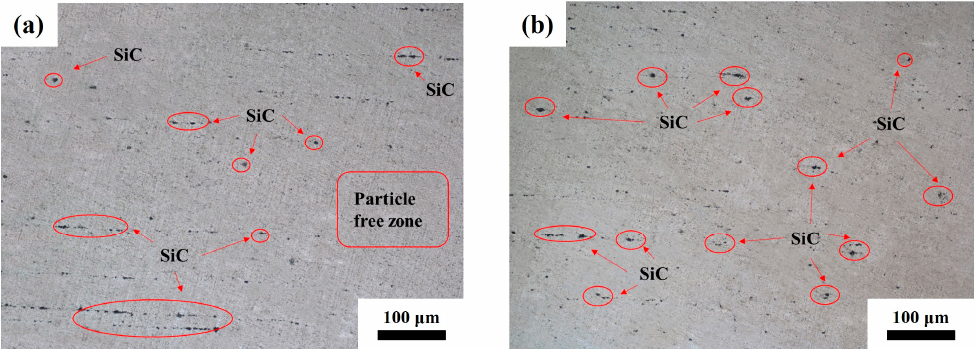
Figure 4. Optical micrographs of the bonding interfaces in the M3 samples after three ( a ) and four ( b ) MARB cycles.